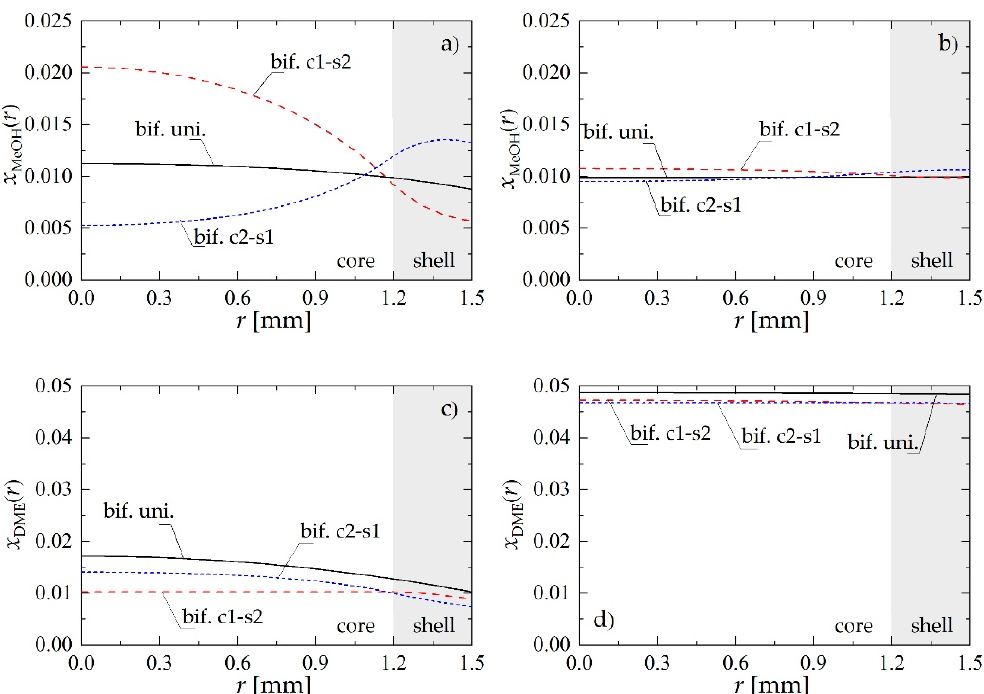
Figure 3. Molar fraction radial profiles within bifunctional catalyst pellet for R p = 1.5 mm and u in = 0.05 m · s − 1 : ( a ) MeOH molar fraction at a distance of z = 0.5 m from the reactor inlet; ( b ) MeOH molar fraction at the reactor outlet; ( c ) DME molar fraction at a distance of z = 0.5 m from the reactor inlet; ( d ) DME molar fraction at the reactor outlet.